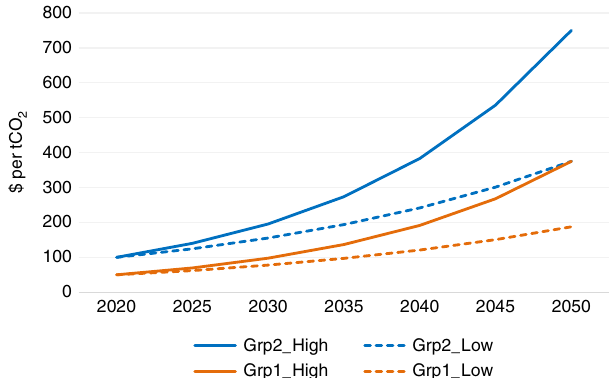
Fig. 4 Carbon tax levels applied to fossil production in different HDI groups, 2020 – 2100. a Different carbon tax level trajectories applied across different HDI groups, with upper side of wedge being high tax variant and lower side of wedge being low variant. b Tax level trajectory variant for more rapid increase in tax levels, where high tax level in 2100 under ( a ) is implemented by 2050, and then held constant to 2100. Source data are provided as a Source data fi le.